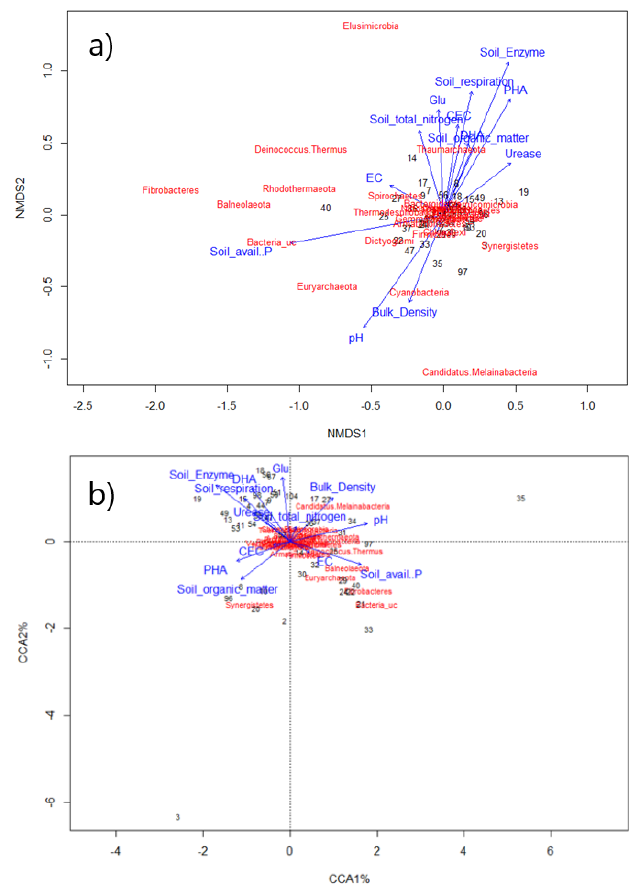
Figure 4. Results of ( a ) non-metric multidimensional scaling (NMDS) and ( b ) canonical correspondence analyses (CCA) for bacteria in the 30 soil samples with physicochemical data.